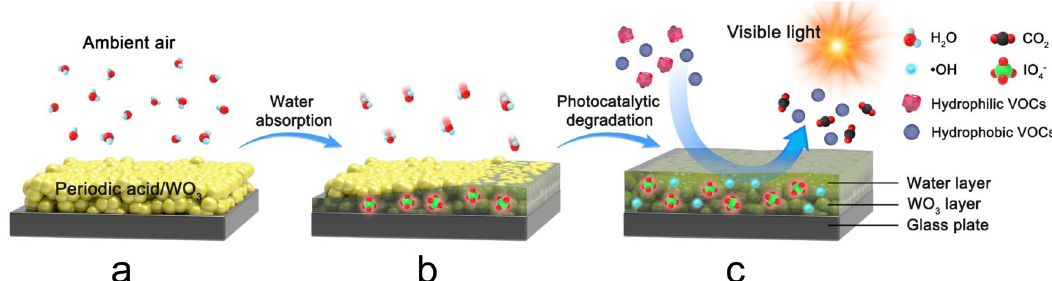
Fig. 7 Schematic illustration of the working mechanism of PA/WO 3 photocatalysis for the selective PCD. a WO 3 is coated with periodic acid (PA) to form PA/WO 3 . b In situ surface water layer is formed due to the hygroscopic property of PA in ambient air while the periodate ions (IO 4 − ) in the in situ water layer serve as ef fi cient electron acceptors. c Under visible light, the photogenerated electrons are rapidly scavenged by IO 4 − while holes produce (cid:129) OH radicals which subsequently degrade hydrophilic VOCs dissolved into the in situ water layer. However, hydrophobic VOCs remain intact during photocatalysis due to the “ water barrier effect